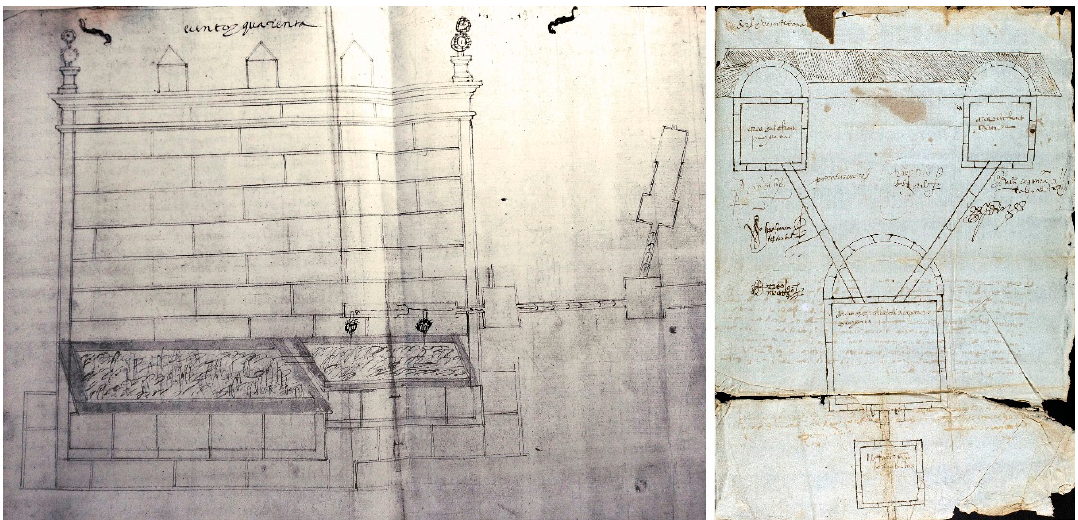
Figure 13. To the right , Gregorio do Barro’s 1580 plan for the Fountain of San Pedro. Provincial Historical Archive of Lugo: Maps, plans and drawings, No. 103. To the left , Pedro de la Bárcena’s version of the 1583 plan. Provincial Historical Archive of Lugo: Notarial protocols, 0014-01. f. 140.